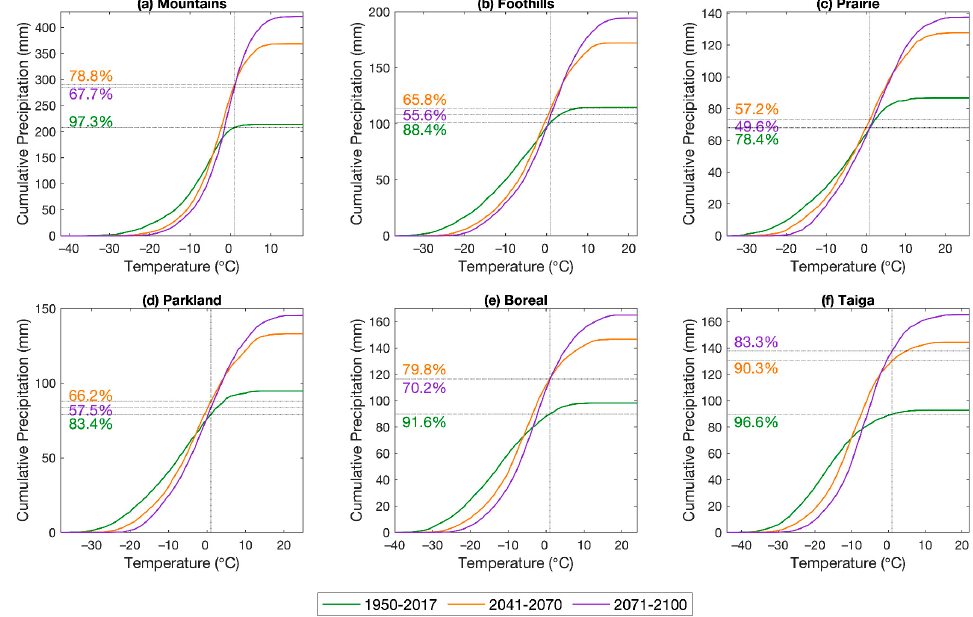
Figure 10. Cumulative precipitation by temperature distribution for RCP 8.5. Snowfall fraction is shown as a percentage of total precipitation along the left side of each ecozone graph.